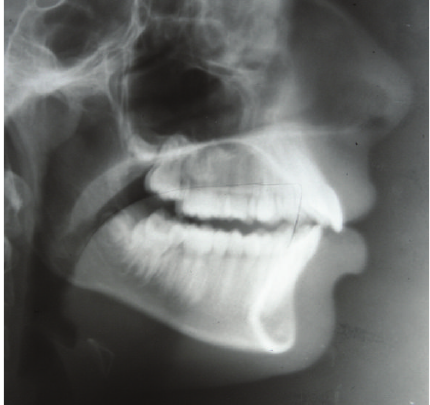
Figure 6: Cephalogram after 6 months of HHCA therapy showing low positioning of tongue at rest